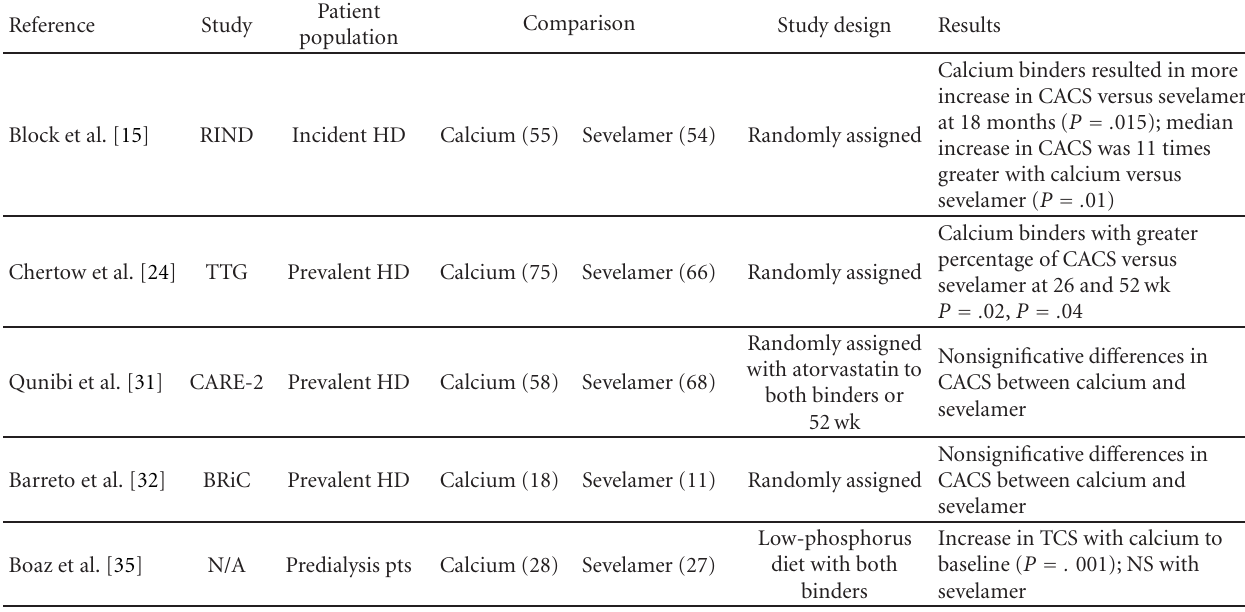
Table 1: A study analyzing the e ff ect of non-calcium-based phosphate binders.